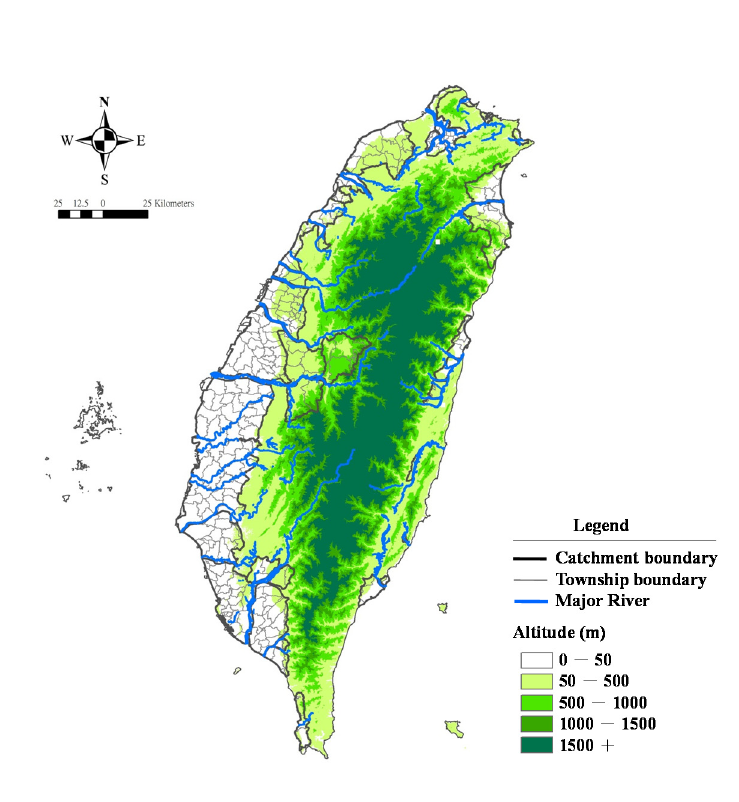
Figure 1. Study areas for urbanized townships in